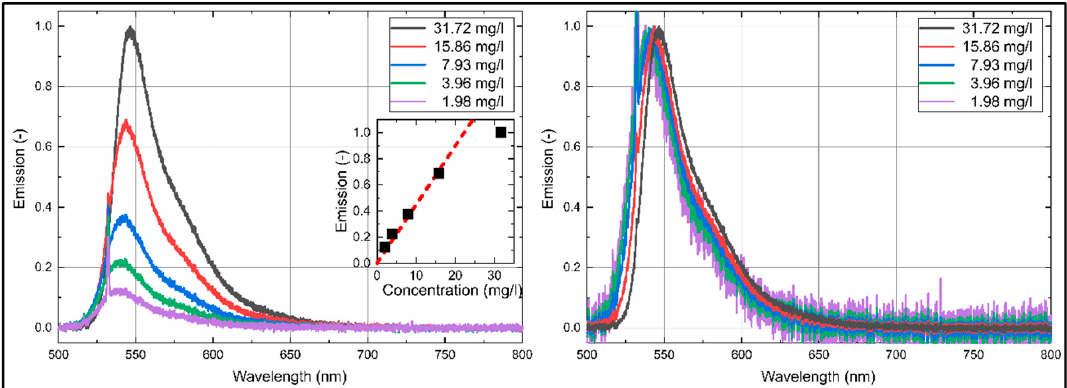
Figure 6. Emission spectra ( left : normalized to maximum intensity of 31.72 mg/L; right : normalized to the respective maximum intensity) of Eosin-Y dissolved in water, inserted diagram show linearity ( R 2 = 0.993) of the integral LIF-signal for various dye concentrations; 293 K, 0.1 MPa.